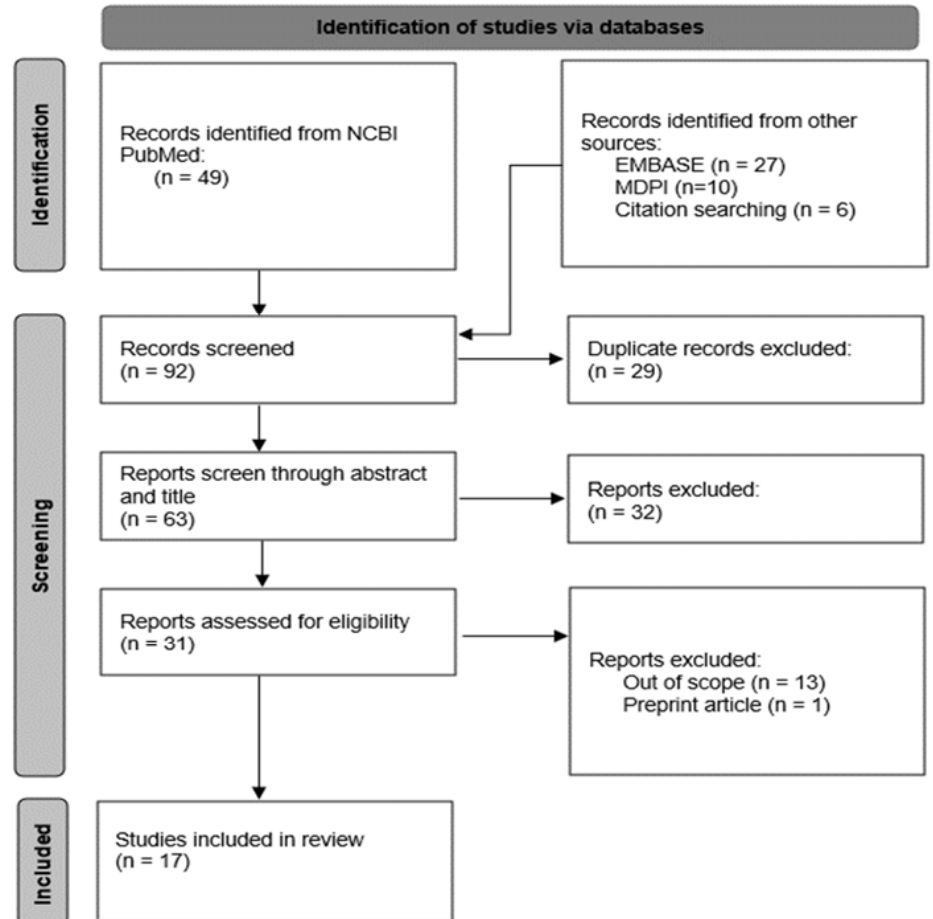
Figure 1. PRISMA flow diagram of search and selection process .